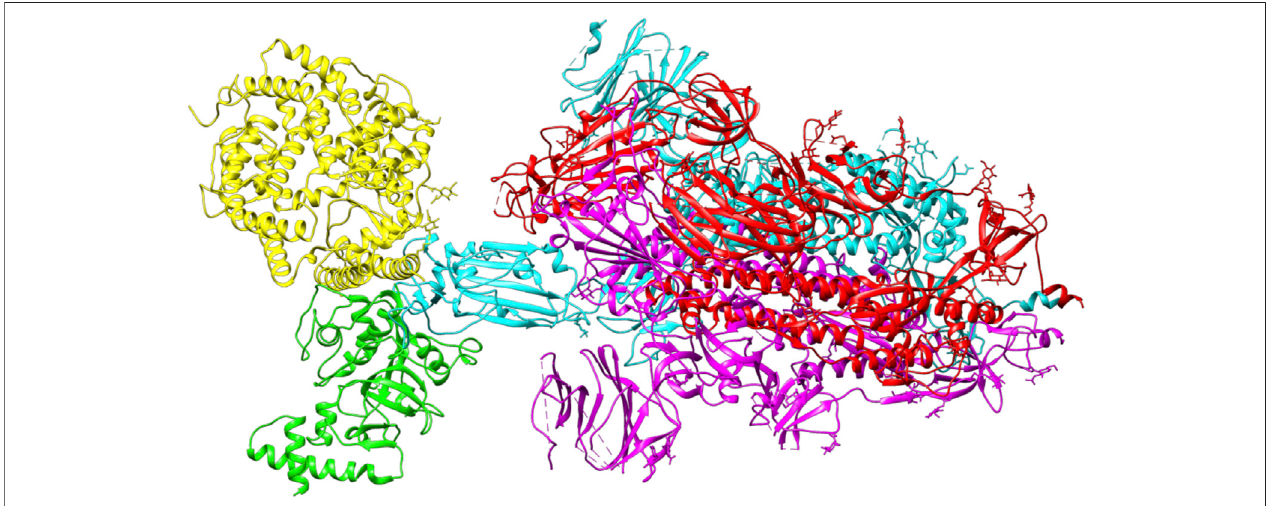
FIGURE 9 | The competitive binding model between bromelain (green) and the ACE2 receptor (yellow) on the binding site of RBD (light blue) of the spike glycoprotein.